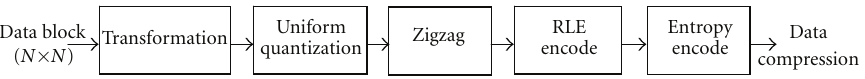
Figure 19: A general JPEG compression